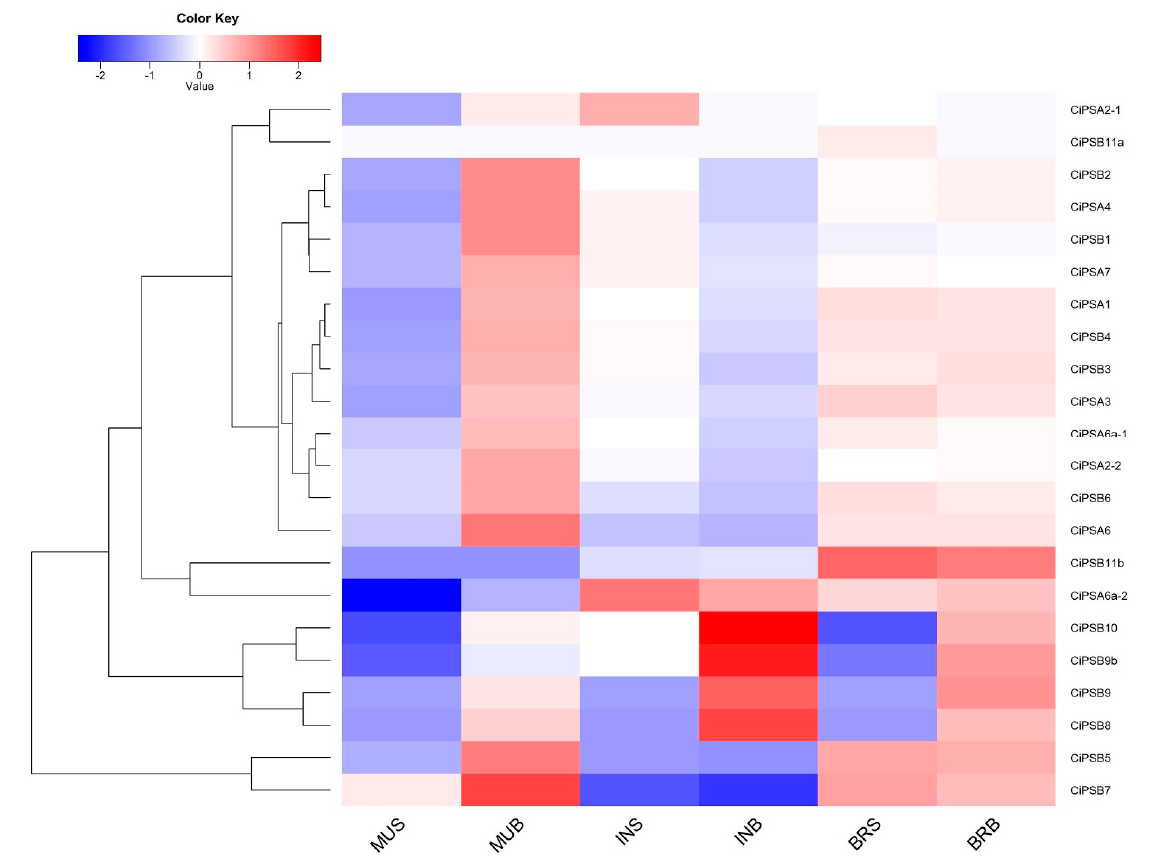
Figure 7. Expression profile of CiPS gene family members response to high density stress in grass carp. Note: S group: Grass carp high-density culture (40 kg m − 3 ); B group: normal culture (3 kg m − 3 ); MUS represents muscle in S group, MUB represents muscle in B group; INS represents intestine in S group, INB represents intestine in B group; BRS represents brain in S group, BRB represents brain in B group.